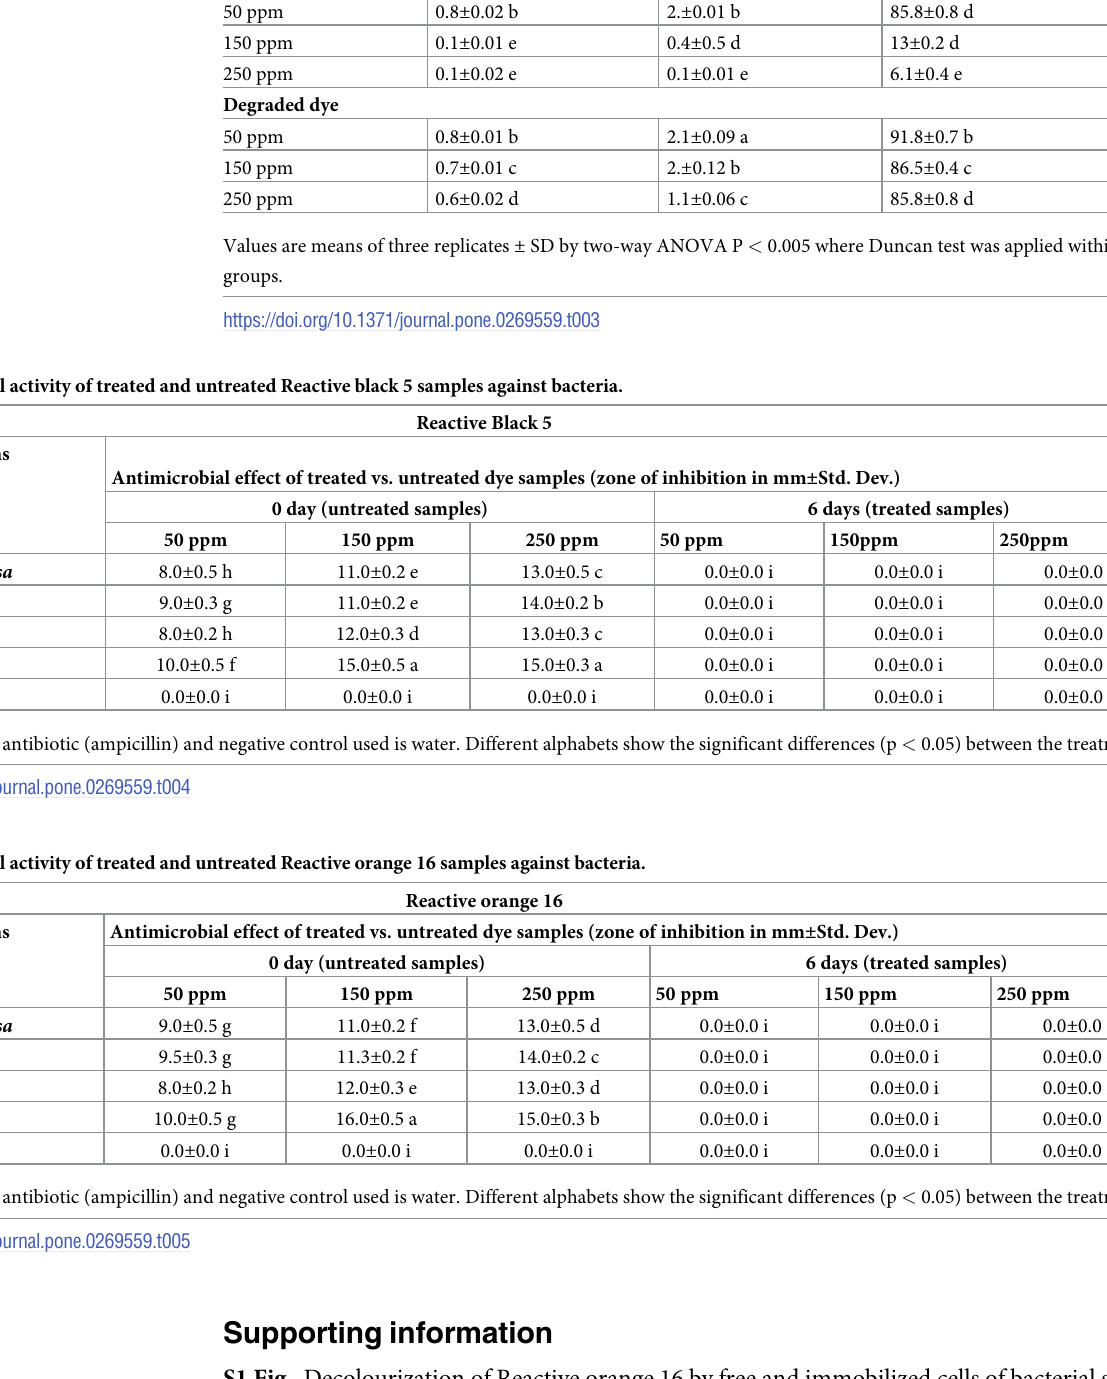
S1 Fig. Decolourization of Reactive orange 16 by free and immobilized cells of bacterial strain (A) by free cells at 30 ˚C (B) by immobilized cells at 30 ˚C. (TIF)